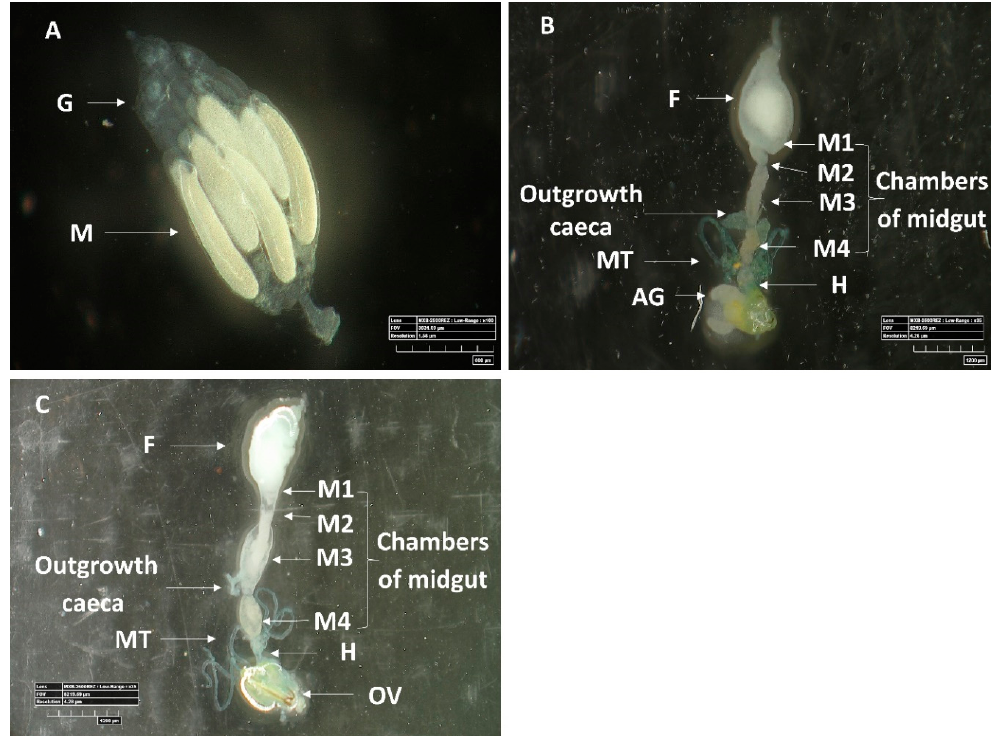
Figure 2. Relative abundance (%) of bacterial microbiota composition of M. pygmaeus (five replicates, pools of 20 females each) based on amplicon sequencing of bacterial partial 16S rRNA gene (V4 region). Amplicon sequence variants were determined and quantified per sample using the Dada2 pipeline and taxonomically assigned by alignment to the Silva rRNA gene database (Table S1). Ma, M. pygmaeus .